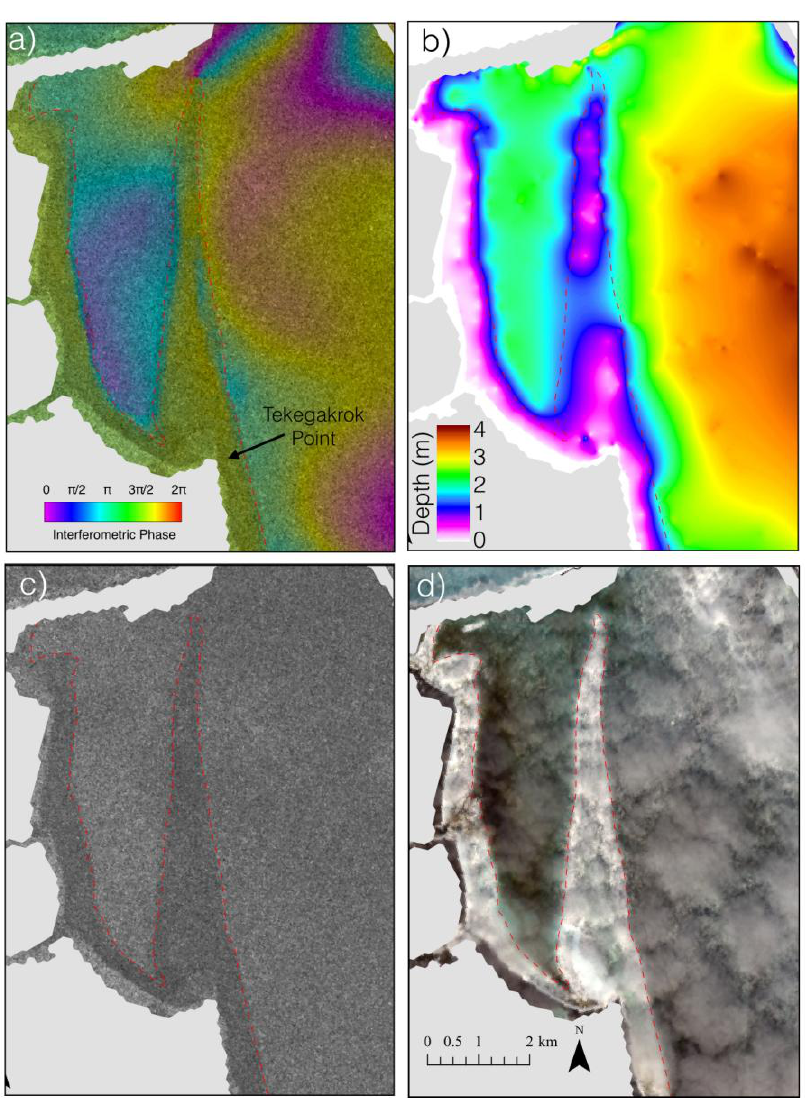
Figure 6. Western part of Elson Lagoon, near Point Barrow, Alaska. ( a ) Sentinel-1 interferogram between 25 April and 9 May 2017 superimposed on backscatter from 25 April 2017; ( b ) interpolated depth; ( c ) Sentinel-1 backscatter from 25 April 2017; and ( d ) Landsat 8 image from 27 May 2015. Dashed red line is based on outline of bottomfast ice as seen in ( d ). Land is masked out in light gray.